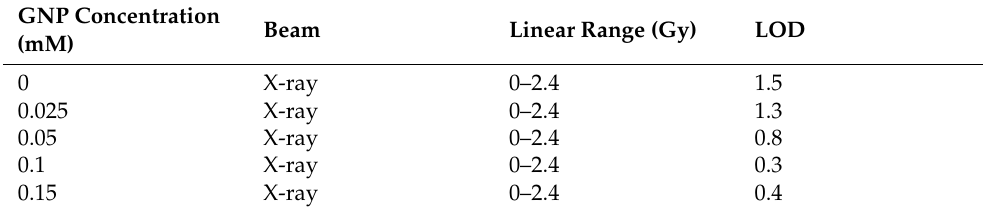
Figure 5. Dose-response of hydrogel sensor with different GNP sizes of 30 nm ( A ), 50 nm ( B ), and 70 nm ( C ), and their fitting slopes ( D ). Table 1. Limit of detection of the hydrogel